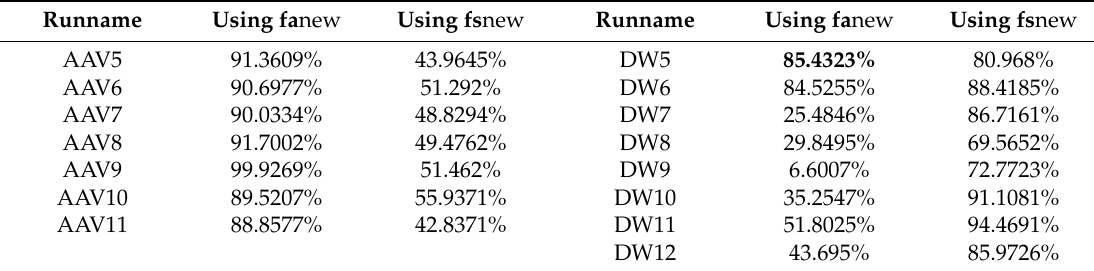
Table 4. Classification accuracy with different feature